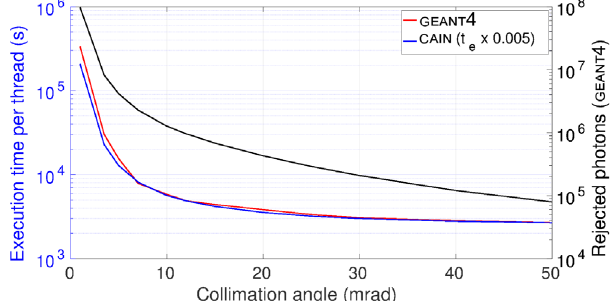
FIG. 10. Time ( t ) required to simulate 10 6 collimated photons e with GEANT 4 (blue curve) and CAIN (red curve), in the case of the BriXS source. The simulations were carried out on a server equipped with an Intel(R) Xeon(R) Gold 5220R CPU and 96 GB of RAM, and the reported execution times refer to single-thread mode. The number of rejected photons using the algorithm implemented in GEANT 4 is also plotted (black